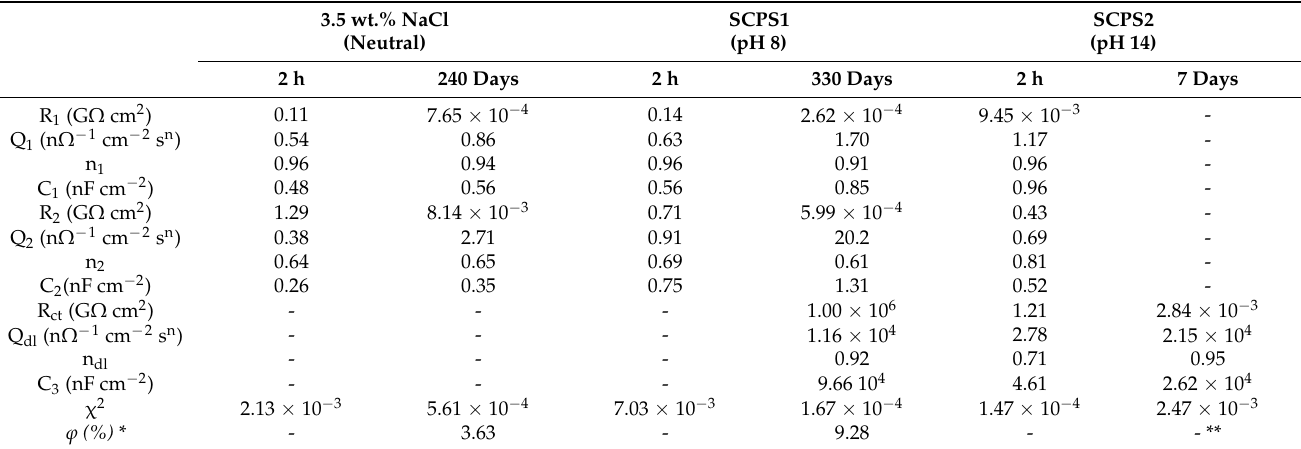
Table 6. Electrochemical parameters obtained by fitting the EIS data of the D0.4 epoxy–silica coating after immersion in NaCl and SCPS solutions, using the EEC shown in Figure